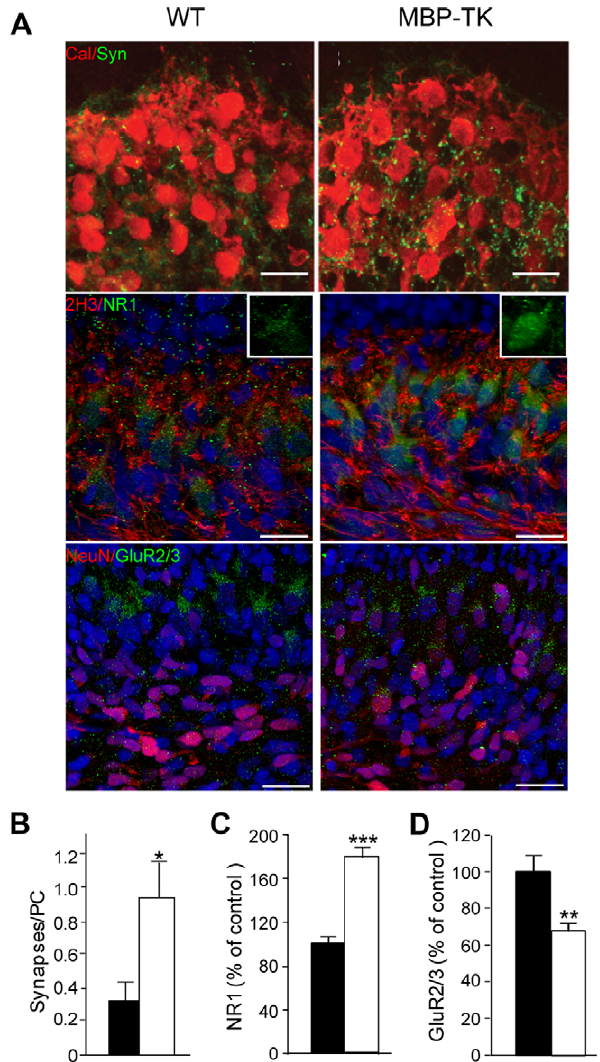
Figure 3. Oligodendrocyte ablation affects synapse formation and remodeling at P1. (A) Top panel: Double immunostaining with antibodies directed against calbindin (Cal, red) and synaptophysin (Syn, green) showed an important increase of synaptophysin staining in MBP- TK treated animals as compared to WT treated littermates. Middle panel: double immunostaining using antibodies directed against (160 KDa) neurofilament (2H3, red) and NMDAR subunit NR1 (green) showing differences in NR1 localization between WT and MBP-TK treated mice. Insets (scale bar 12.5 m m) show NR1 localization on PC soma and dendrites in the WT whereas in MBP-TK mice NR1 staining appears internalized. Bottom panel: double immunostaining directed against Neu N (red) and AMPAR subunit GluR2/3 (green) showing a decrease of GluR2/3 staining in MBP-TK treated animals. (B) Quantifi- cation of synapses number on PC’s bodies performed on EM specimen at P1 (4 h after treatment) revealed a 3.2 fold increase of synapse number in MBP-TK versus WT PCs (n=20 images, P , 0.05). (C and D) Quantification of NR1 and GluR2/3 staining intensities in MBP-TK mice versus WT siblings, respectively. Black bar: WT, White bar: MBP-TK. Values are mean 6 SEM. *P , 0.05, **P , 0.01, ***P , 0.001. Scale bar 20 m